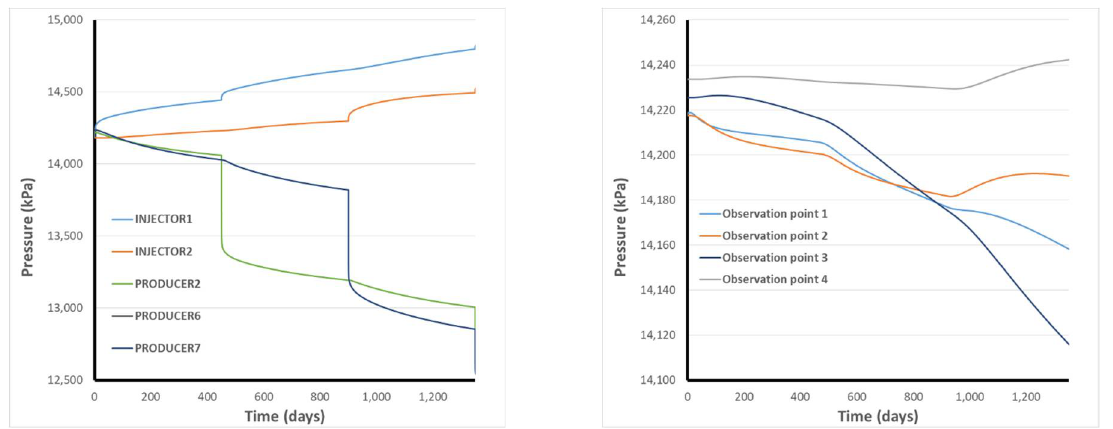
Figure 2. Pressure changes over time during the history matching period: ( a ) transience near the wells; ( b ) transience at observation points.